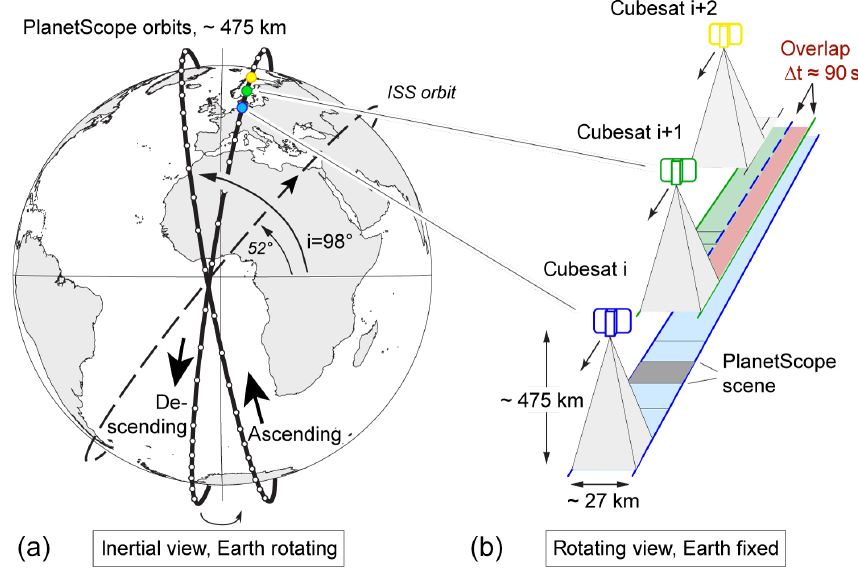
Figure 2. Planet orbits. (a) Inertial view: the final PlanetScope descending and ascending orbits (bold) and the ISS test-bed orbit (dashed). Cubesat positions (white dots on the orbits) are only schematically indicated. (b) Rotating view: the complete scan scheme of the Earth surface by successive PlanetScope cubesats in the same orbit producing a time lag of around 90s over the swath overlaps.